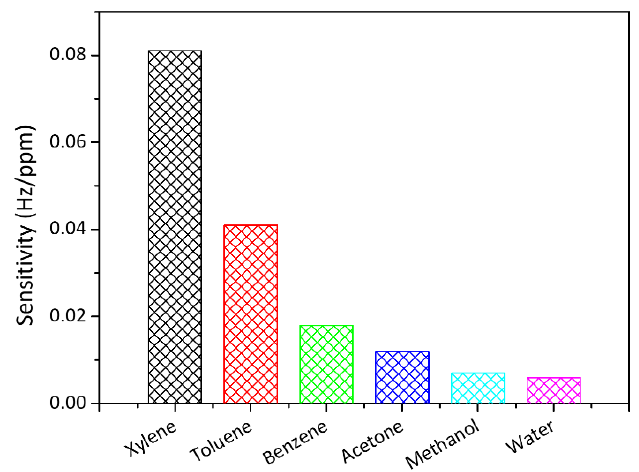
Figure 5. Sensitivity of PVAc film QCM sensor towards different analytes.